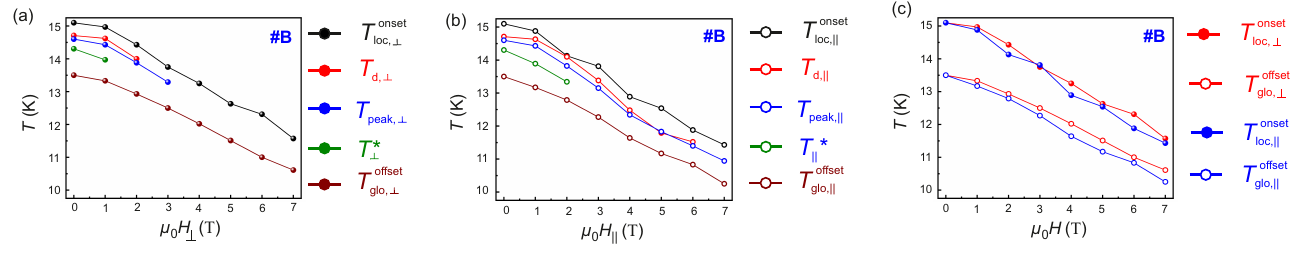
, T d , T peak , T = T ∗ and T offset as a loc glo recorded for #B. loc, ⊥ / (cid:107)